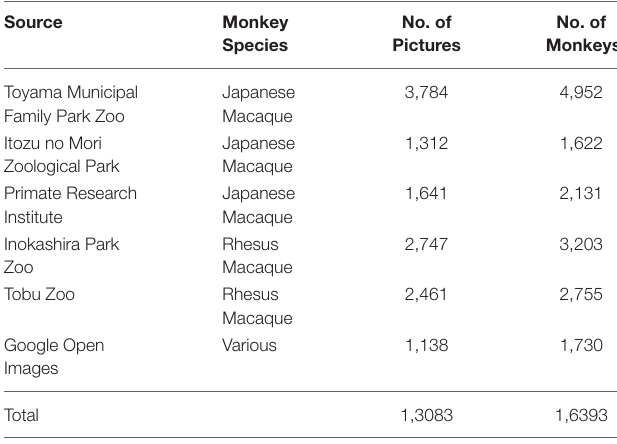
TABLE 1 | The number of pictures and monkeys in the present dataset from each source. Source